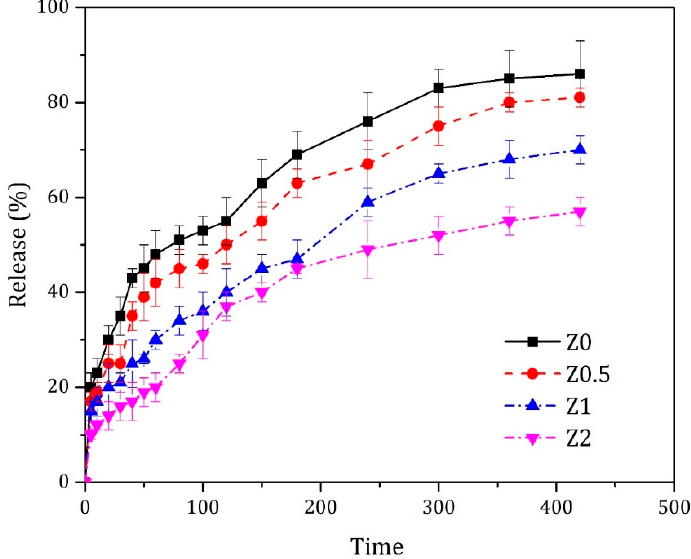
Figure 7. PX release rate from hydrogel composite in different percentage of zeolite.